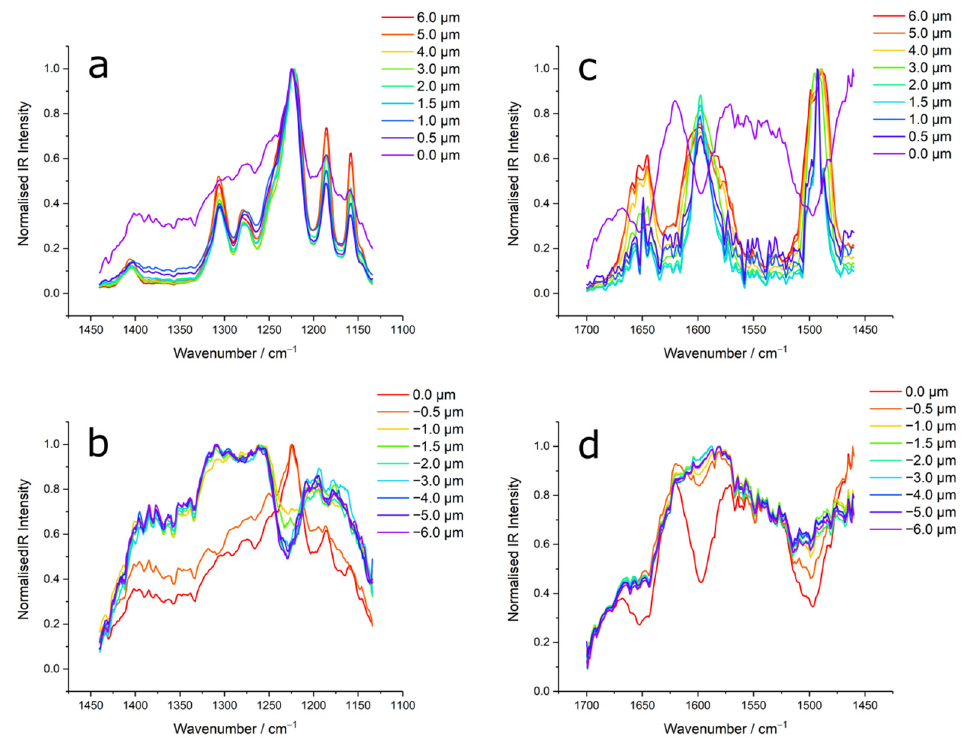
Figure A3. AFM-IR spectra of the PPB domains shown in Figure 4 overlapped to emphasize variations in the relative band intensity. The spectra in the ‘high’ domain are shown in ( a , c ) and those in the ‘low’ domain in ( b , d ).